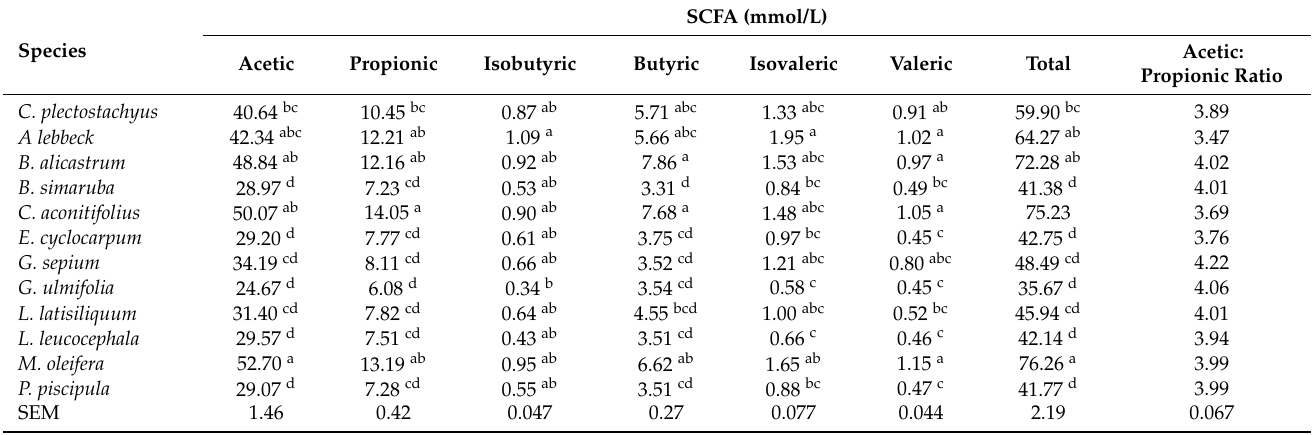
Table 5. Production of short-chain fatty acids (SCFA) at 72 h of in vitro ruminal fermentation of the foliage of tropical trees and